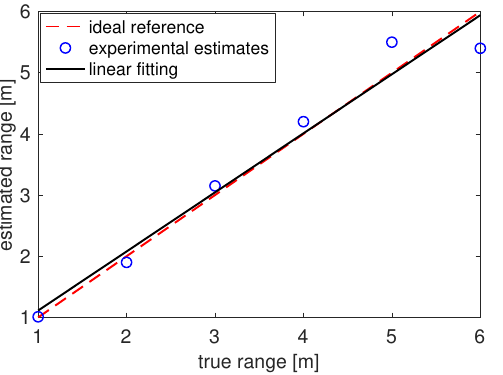
Figure 10. Echo-location performance in terms of estimated distance vs. actual distance.